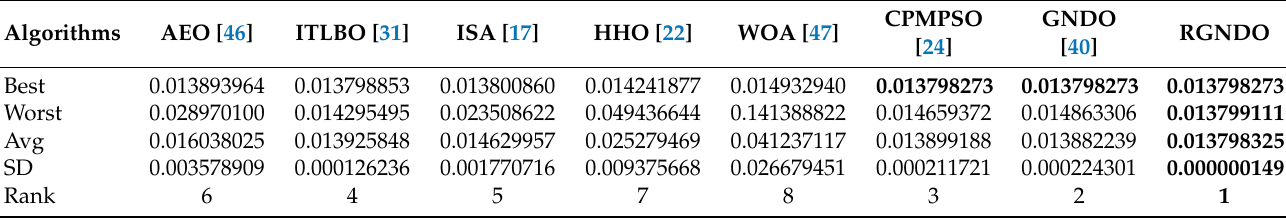
Table 12. Comparison of the fitness on